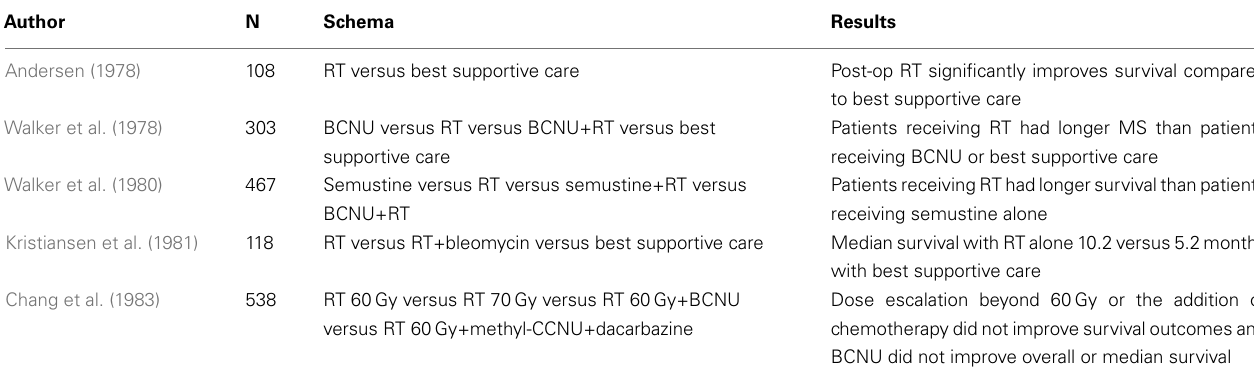
Table 1 | Role of radiotherapy in